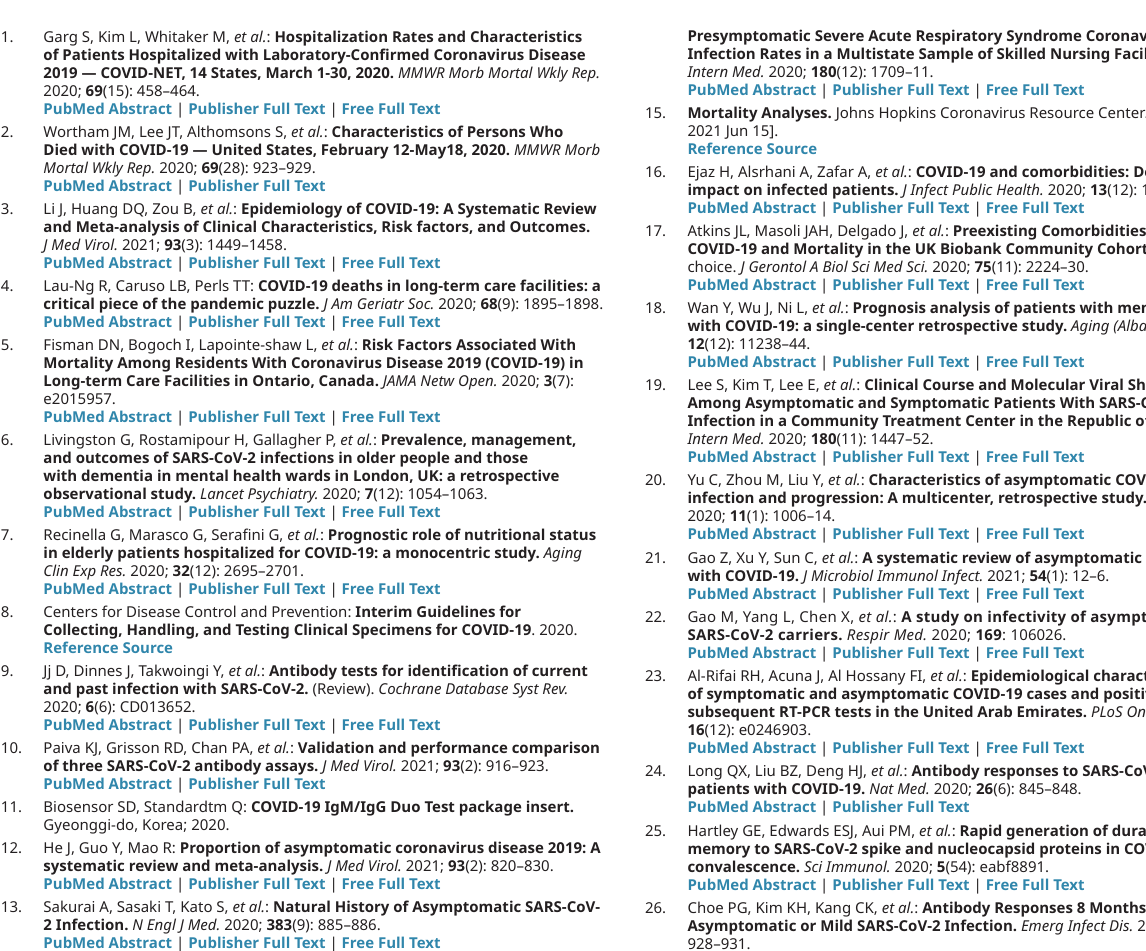
Figshare. “Asymptomatic COVID-19 in the elderly: dementia and viral clearance as risk factors for disease progression”. Stata